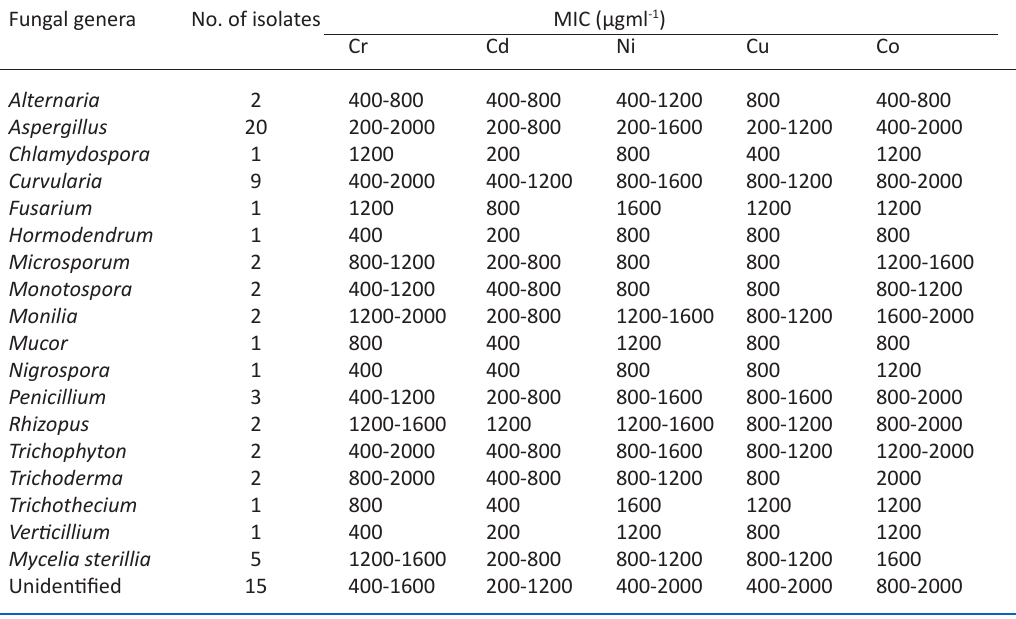
Table 5. Minimum inhibitory concentration (MIC) range of heavy metals against 73 soil fungal isolates Fungal genera